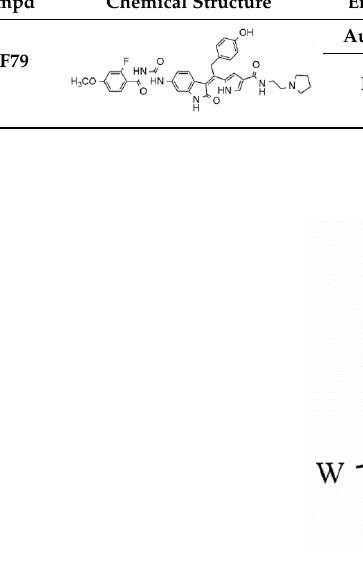
Figure 6. Promising indolin − 2 ‐ one molecular pattern for dual Aurora B/FLT3 activity.